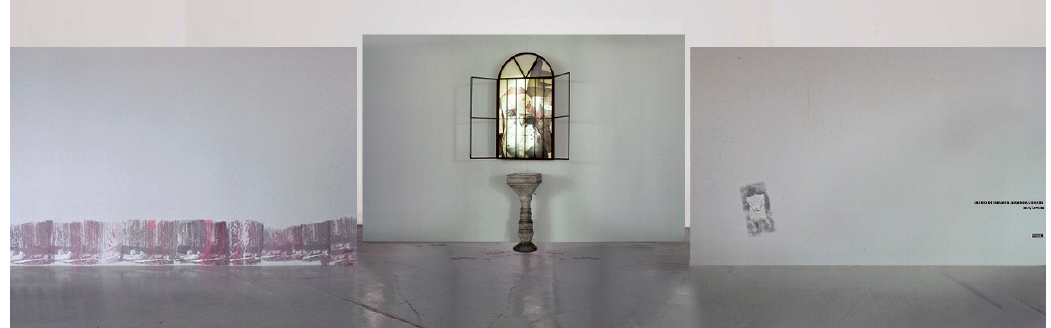
Figure 15. Josely Carvalho, Cirandas II , 1994. Installation: silkscreen on walls, light box window, U.N. Declaration of Children’s Rights printed under water in baptismal font. Exterior view. Museu de Arte Contemporânea MAC/USP, São Paulo. Courtesy of the artist.